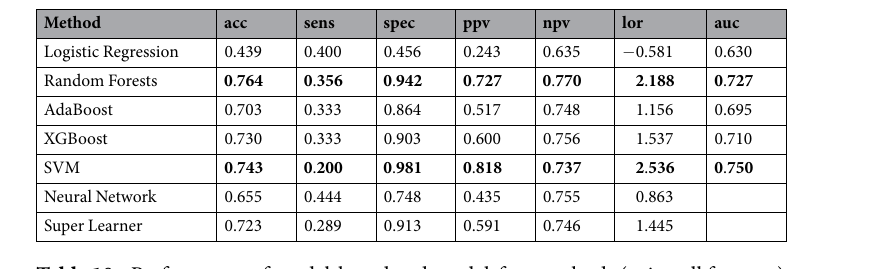
Table 10. Performance of model-based and model-free methods (using all features).